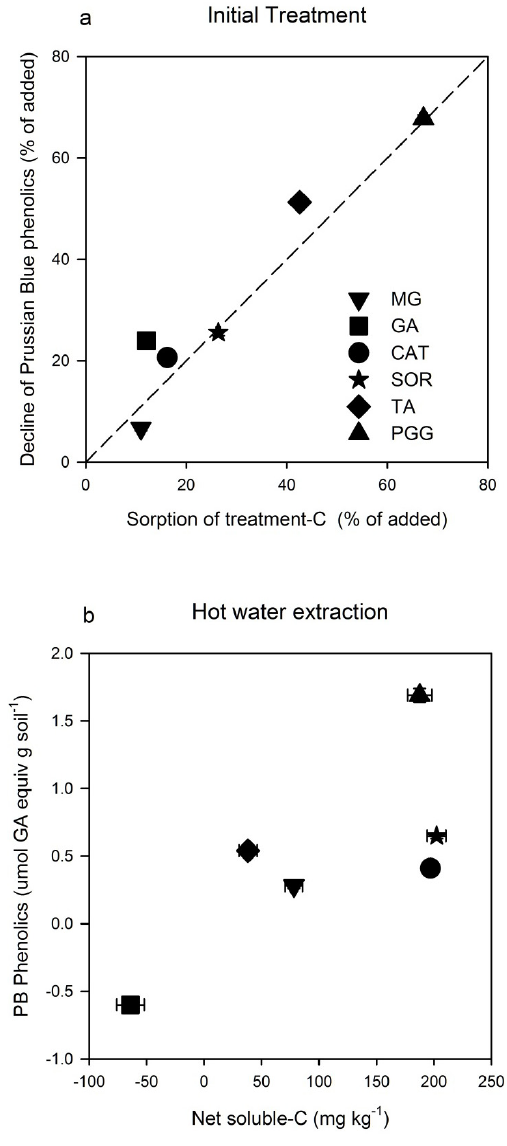
Figure 2. Mean (n = 96) and standard error ( a ) Percent reduction of Prussian blue (PB) phenolics, and percent of treatment-C sorption (from Table 3); and ( b ) Soluble-C and total phenolics in hot water supernatant. Total phenolics were determined by the Prussian Blue assay and are expressed in ( a ) as percent of the input values from Table 2, or in ( b ) as μ moles gallic acid